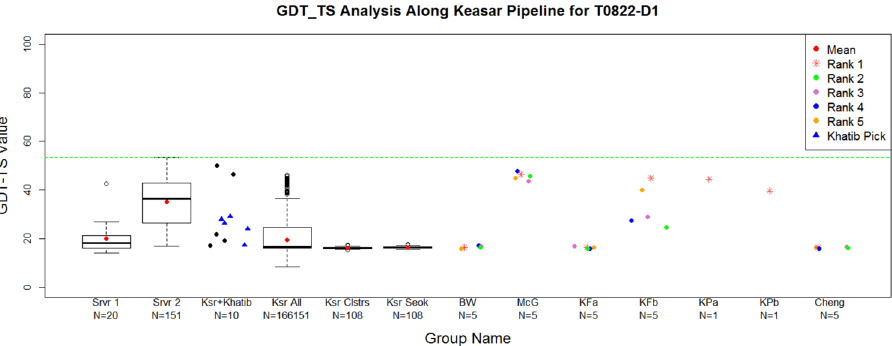
Figure 6. Box and whiskers plots represent the steps in Keasar-Foldit-based pipelines for target T0822-D1. First column represents the 20 models created by the servers at stage 1. Second column represents the 151 server models that are made available by the CASP organizers (stage 2). Keasar selects a subset of 10 server models using MESHI. These models are marked as dots in the third column. Then Khatib selects 5 of those models (marked with triangles). Khatib’s selected models (starting points) are given to the Foldit players. The Foldit players created a wide range of models, some of which were substantially better than the starting points as shown in column 4. However, column 5 shows that the clustering and filtering algorithm did not select those best models. Column 6 shows the clusters after refinement by Seok’s lab. Columns 7–13 represent the final selection by different WeFold groups, which selected either exclusively from the clusters in column 6, or from a combination of these and Zhang’s clusters, or from a combination of all the models shared by various WeFold groups and servers. Green line is the best model submitted to CASP11 for that target considering all the CASP11 groups. Note that the tick labels along the x-axis also show the number of models in each step of the pipeline. Box and whiskers plots for all the other targets attempted by the Keasar-Foldit pipelines and Zhang pipelines are in the Supplementary